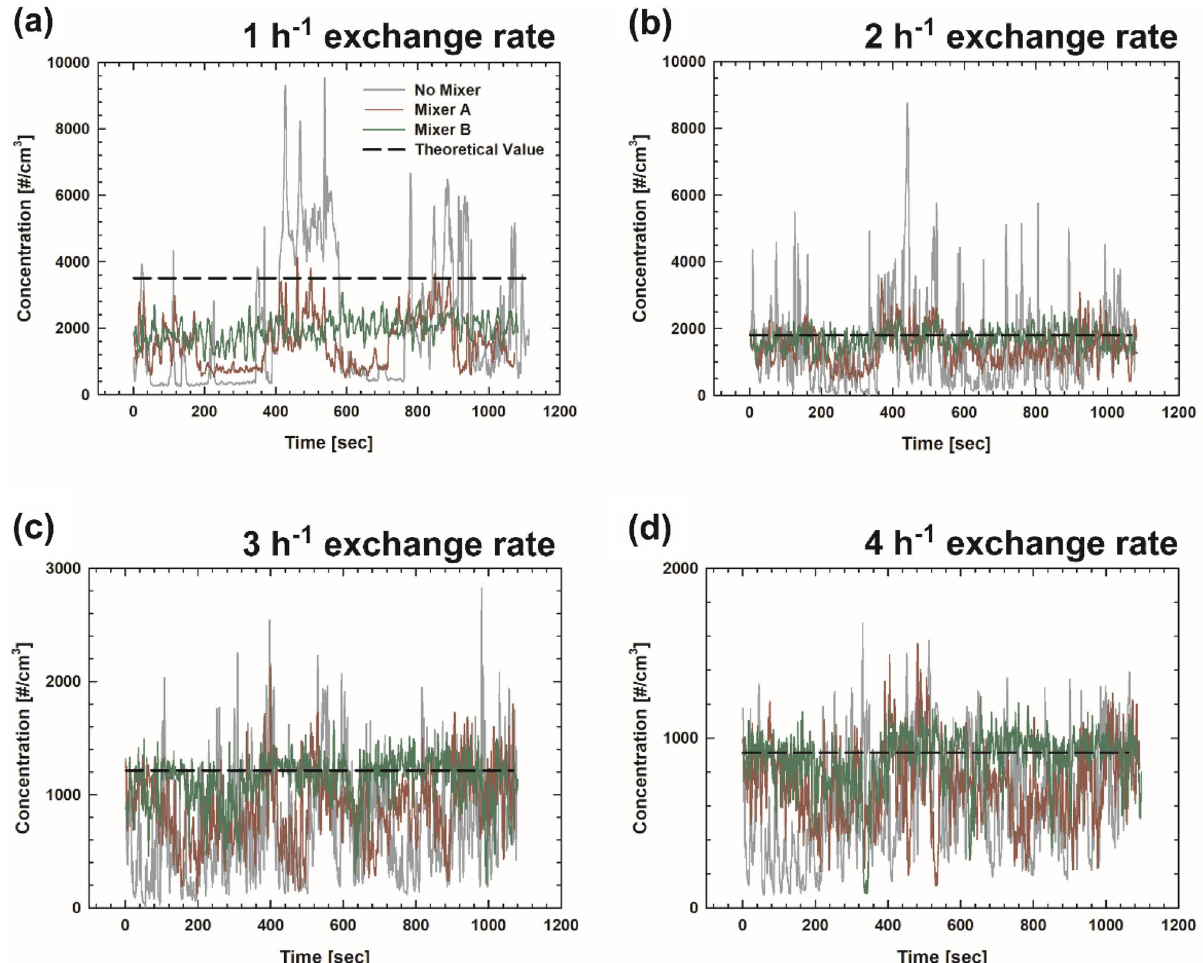
Figure 4. Concentration as a function of time measured at the center of the sampling location (sampling point 3 in Fig. 1a) with and without a mixer for the exchange rate of ( a ) 1 h −1 , ( b ) 2 h −1 , ( c ) 3 h −1 , and ( d ) 4 h −1